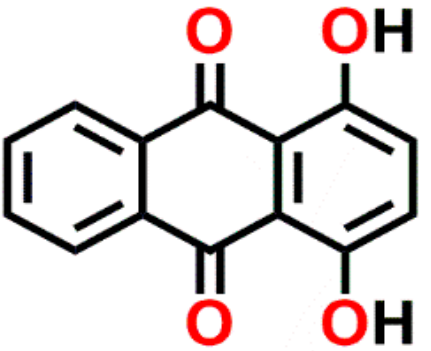
Figure 1. Structure of Quinizarin ( QZ ) fluorescent